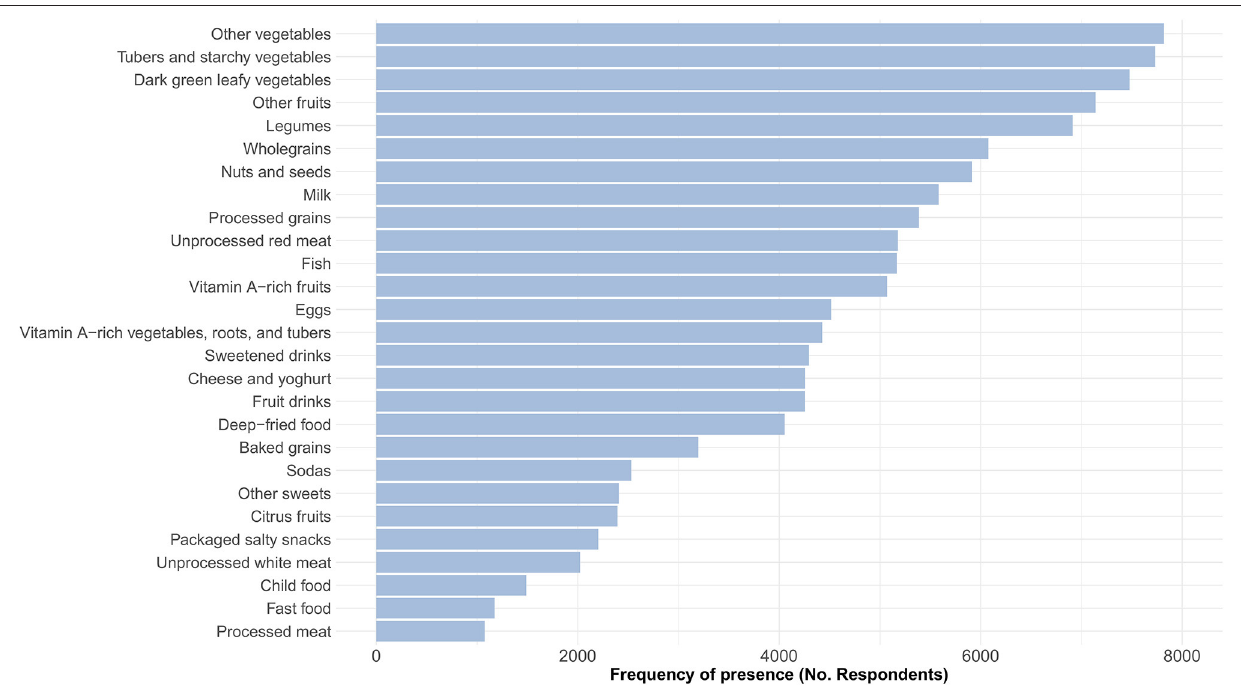
diet quality realities in near real-time. The tool and approach reinforce the utility and benefits of digital data collection and crowd engagement and could be easily adapted to other national